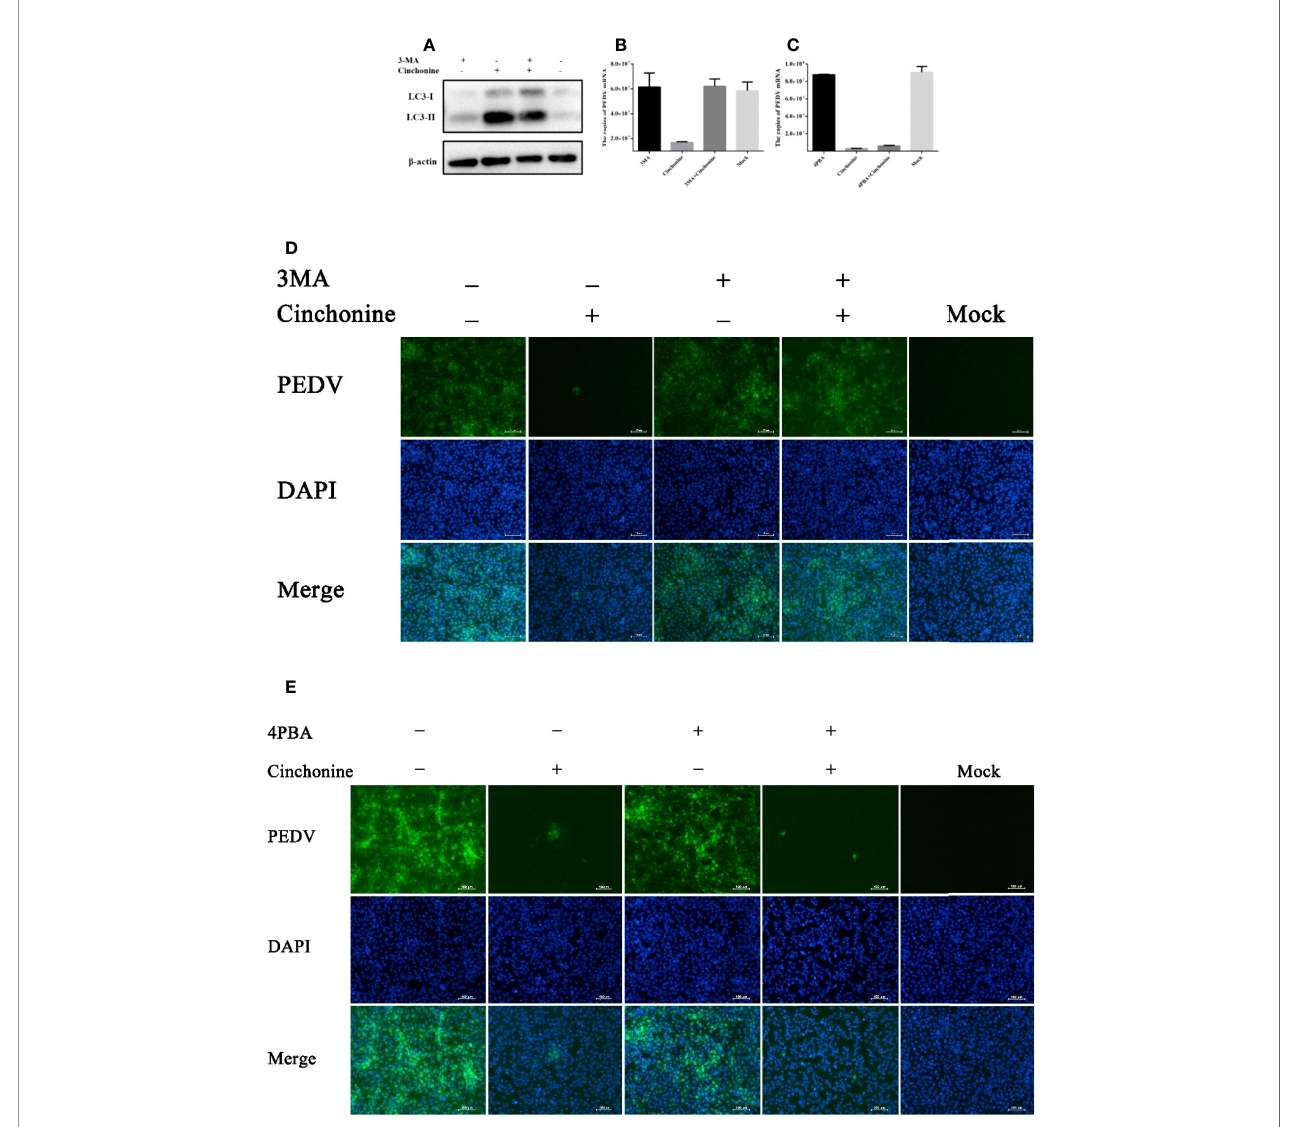
FIGURE 6 | Cinchonine inhibits PEDV infection in Vero CCL81 cells through inducing autophagy. (A) Vero CCL81 cells were treated with or without 3 mM 3MA for 2 h prior to 100 m M cinchonine treatment for 24 h, and then the expression of LC3 was analyzed by Western Blot analysis. (B – E) Vero CCL81 cells incubated with or without of 3MA (3 mM) or 4-PBA (100 m g/mL) were treated with 100 m M cinchonine, and then infected with PEDV. The samples were collected at 24 h post infection to estimate the mRNA level of PEDV by the quantitative real-time PCR, and the number of PEDV infected cells was thereafter evaluated by IFA. The data has been represented as the mean ± SD of at least three independent